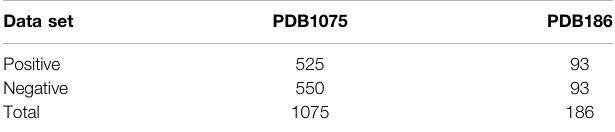
TABLE 1 | benchmark datasets used in this